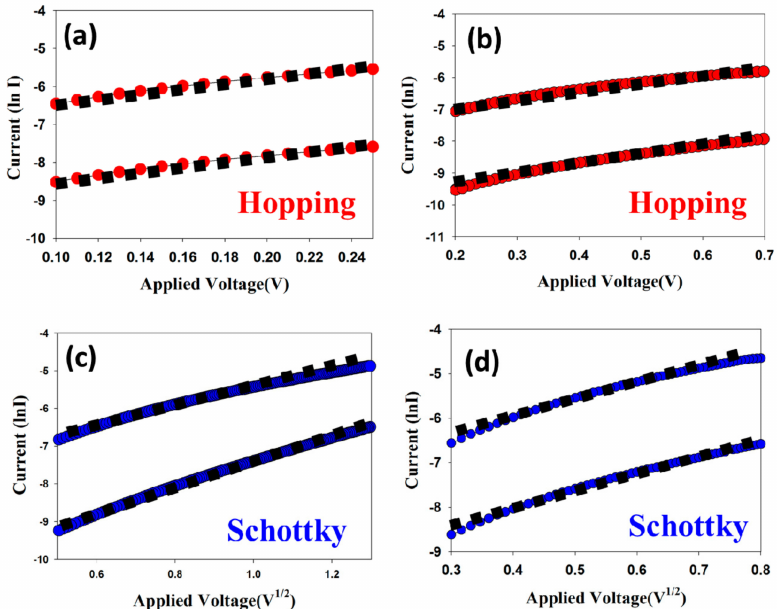
Figure 3. The ln I-V and ln I-V 1 / 2 curve fittings for the hopping conduction mechanism for ( a ) V 2 O 5 and ( b ) Sm 2 O 3 memory devices for the ON / OFF state. The Schottky emission conduction of the ( c ) V 2 O 5 thin films and ( d ) Sm 2 O 3 memory devices for the ON / OFF state.